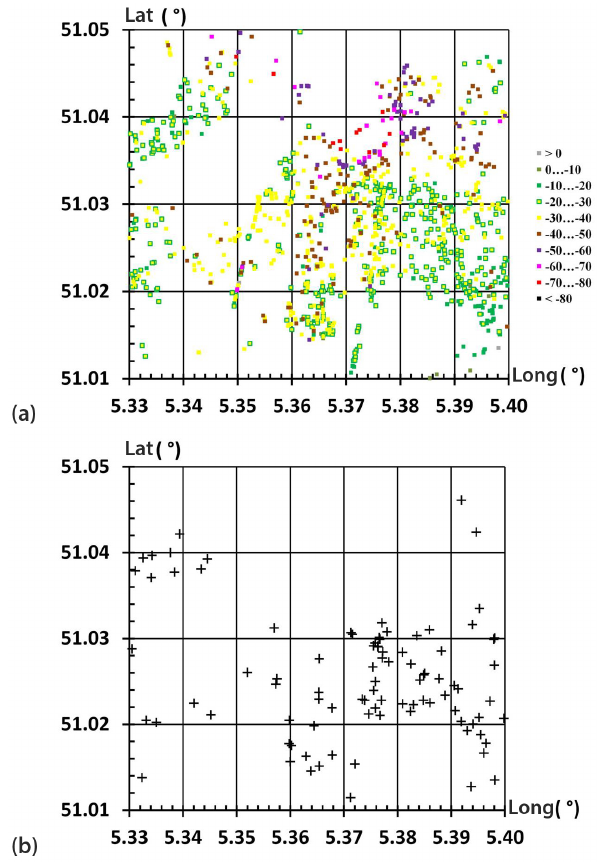
Figure 3. Spatial variation of total surface movement in the area between a latitude of 51.01–51.05 ◦ N, and a longitude of 5.33– 5.40 ◦ E: (a) period 1, 5-year time zone, from mid-August 1992 through mid-August 1997 (all reflectors; color scale is in mm); (b) period 1, 2.5-year time zone, from July 1998 through Decem- ber 2000 (only reflectors with a upward movement during this time zone).